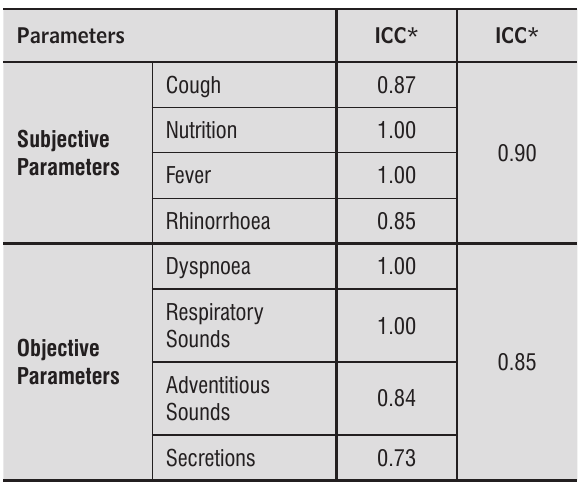
Table 3 - Test-retest reliability of the Paediatric Respira-